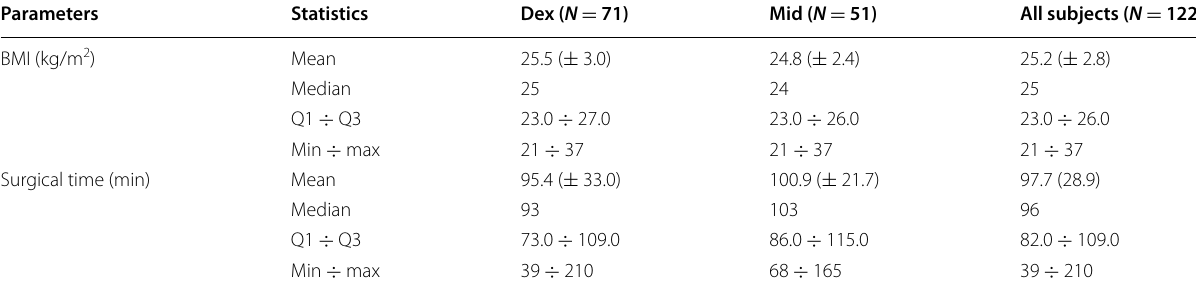
Table 2 Anamnestic parameters of the study population